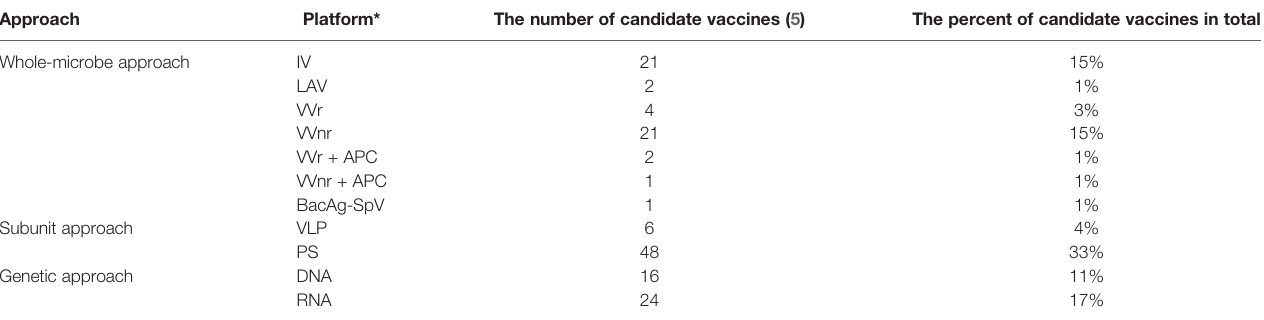
TABLE 2 | The summary of candidate vaccines in clinical